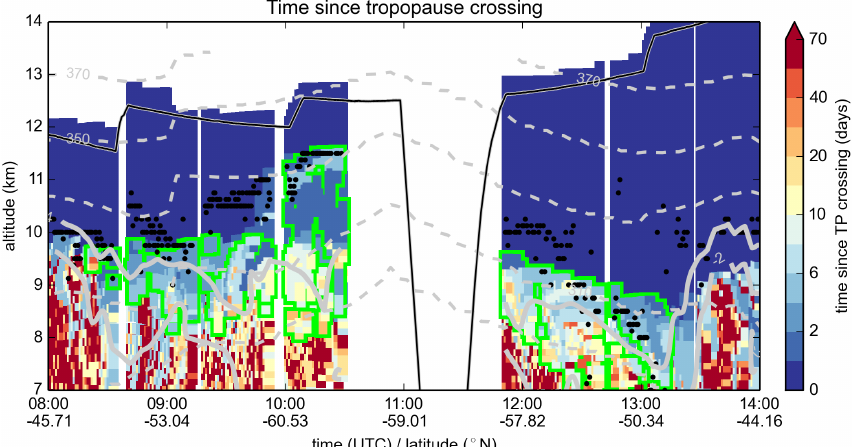
Figure 8. The color code denotes the time since trajectories passed the thermal tropopause from stratosphere to troposphere. Bluish colors denote trajectories which recently passed the thermal tropopause, reddish colors indicate tropopause crossings longer ago. The green-framed areas mark the trajectories where GLORIA observations show water vapor below 3ppmv. The flight path, tropopause height, potential temperature, and PV isolines are the same as in Fig.